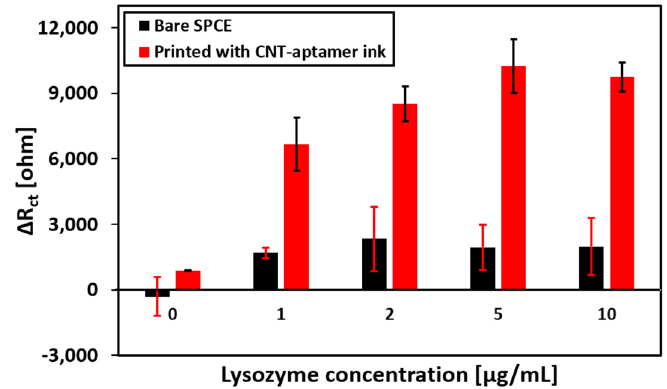
Figure 6. Change of charge transfer resistance (R ct ) due to lysozyme exposure to bare SPCE (black bars) and printed SPCE (red bars) for different lysozyme concentrations.